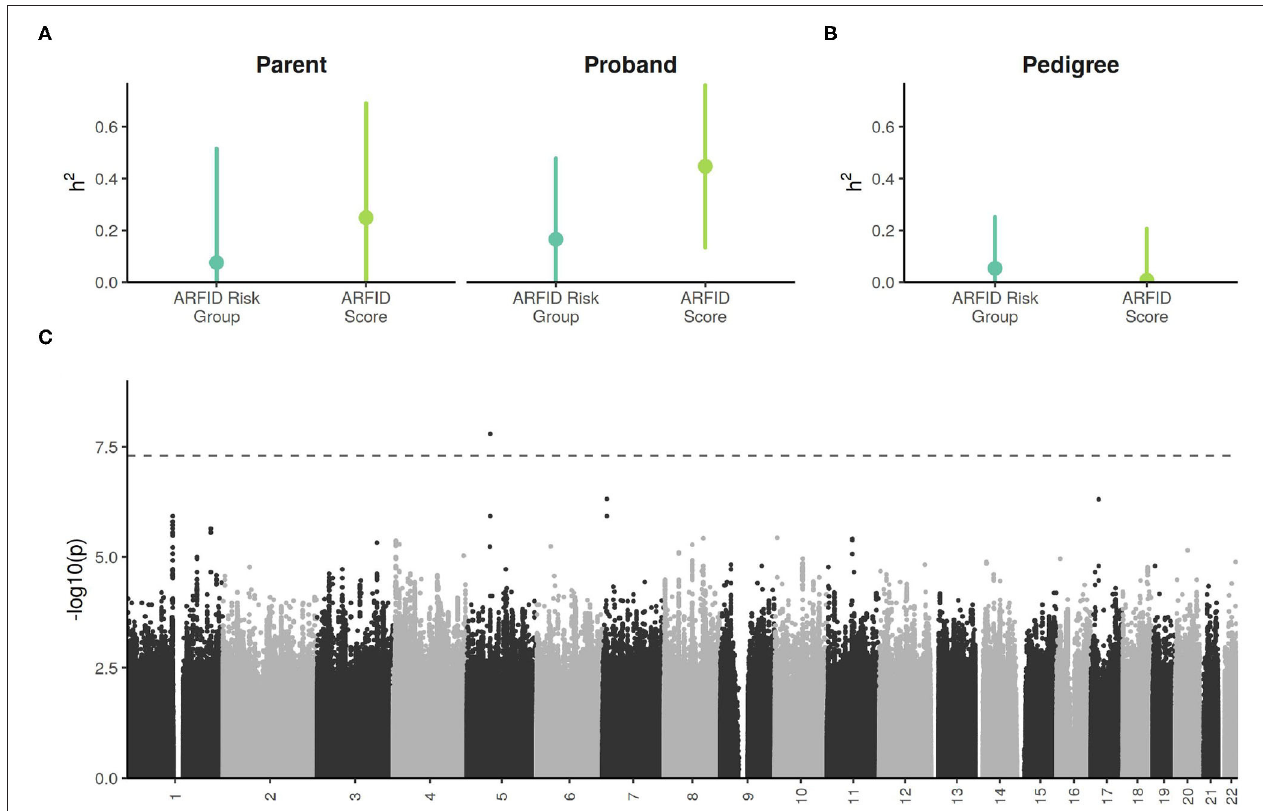
FIGURE 4 | (A) SNP-based (i.e., narrow sense) heritability estimates of ARFID Score and ARFID Risk Group (high vs. low), with 95% confidence intervals. (B) Excess pedigree heritablility estimates (beyond what is explained by SNP h 2 ) ARFID Score and ARFID risk group, with 95% confidence intervals. (C) GWAS Manhattan plot of the proband ARFID Score. The dashed line indicates the genome-wide significance threshold of 5 e − 8 .